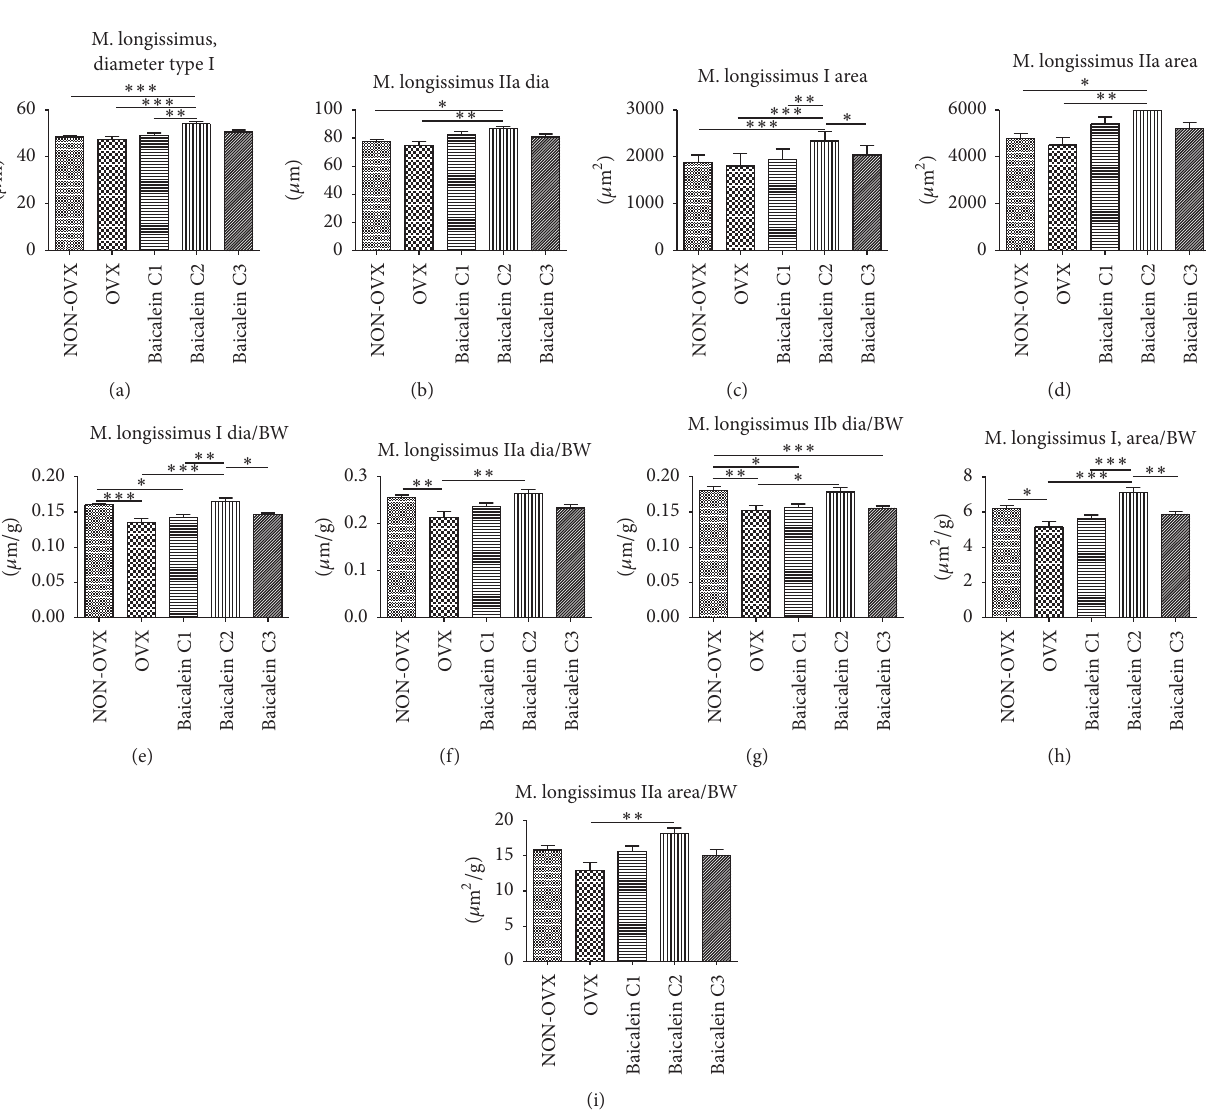
Figure 6: Diameter and area of M. longissimus fibre types I and IIa and their relation to muscle weight and body weights. A significantly greater fibre type I size was noted in the C2 group than in the NON-OVX, the OVX group, and the C1 group ((a), 𝑛 = 46 ). A significantly greater fibre type IIa size was recorded for the C2 group compared with the NON-OVX and OVX groups ((b), 𝑛 = 46 ). Significant differences in the type I fibre area could be detected when the C2 group was compared with the NON-OVX and OVX groups, C1 group, and C3 group ((c), 𝑛 = 46 ). The fibre IIa area was significantly greater in the C2 group when compared with the NON-OVX and OVX groups ((d), 𝑛 = 46 ). Statistically relevant differences in diameter to body weight ratio were noted between the following groups. For type I fibres: NON-OVX versus OVX and the C1 group; OVX versus C2 group, C1 versus C2 group; and C2 versus C3 group ((e), 𝑛 = 46 ). For type IIa fibres, a significant difference was noted between the NON-OVX and OVX and between the OVX and C2 groups ((f), 𝑛 = 46 ). The OVX group showed a significantly less fibre to body weight index when compared with the NON-OVX group and C2 group. Moreover, the NON-OVX group showed a significantly higher index than the C1 and the C3 groups ((g), 𝑛 = 46 ). A significantly lower fibre area to body weight index was noted in the OVX group when compared with the NON-OVX and C2 groups. C2 group showed a higher fibre area to body weight index when compared with the OVX, C1, and C3 groups ((h), 𝑛 = 46 ). C2 group, when compared with the OVX group, showed a significantly higher fibre area to body weight index for the IIa muscle fibres ((i), 𝑛 = 46 ). ∗ 𝑝 < 0.05 , ∗∗ 𝑝 < 0.01 , and ∗∗∗ 𝑝 < 0.001 indicate significant